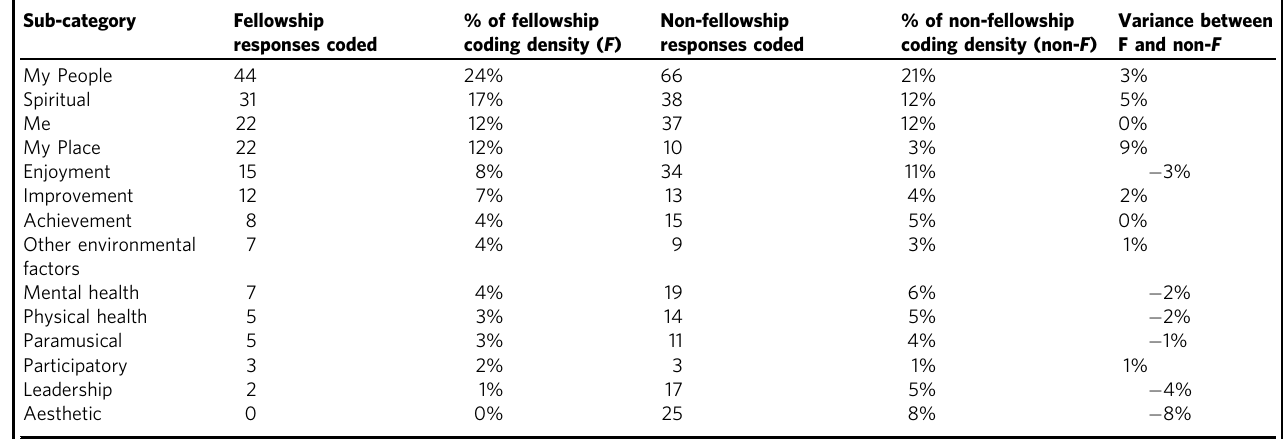
Table 1 Layer 1 thematic